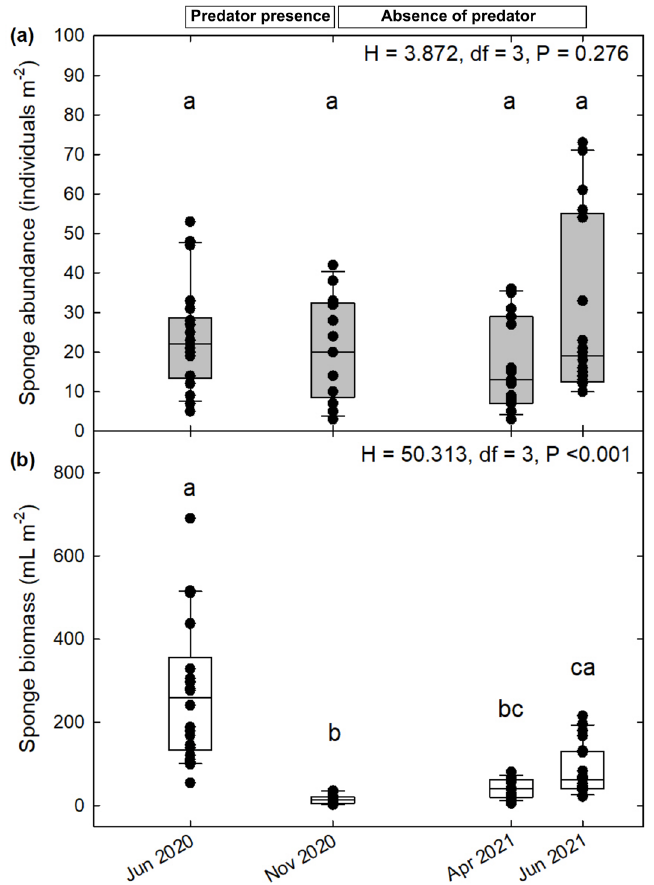
Figure 3. Changes in ( a ) abundance and ( b ) biomass of the sponge Hymeniacidon perlevis during an annual cycle. Boxplots and individual data points are indicated for each sampling date. The number of 1 × 1 quadrats analyzed on each sampling date is n Jun 2020 = 22, n Nov 2020 = 13, n Apr 2021 = 15 and n Jun 2021 = 21. Significant between- season differences of ( a ) abundance (individuals m −2 ) and ( b ) biomass (mL m −2 ) of the sponge population of H. perlevis are indicated with different letters according to the results of Kruskal–Wallis analysis and the post-hoc pairwise Dunn’s tests. The spongivorous nudibranch Doris verrucosa was present from mid-June to mid- November in the area of study. Mean (± SD) values for sponge abundance and biomass, as well as metadata, are available in Supplementary Information